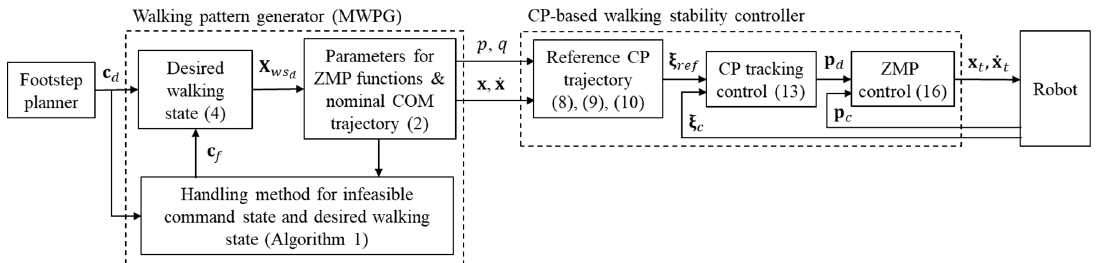
Figure 4. Overall procedure of the proposed method.